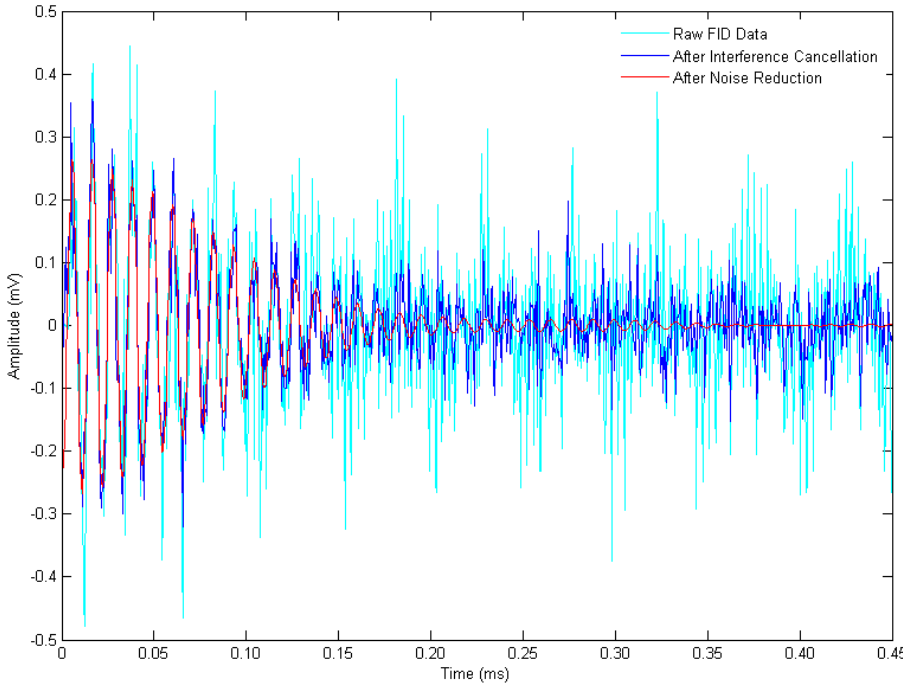
Figure 9. The waveforms of raw FID data (cyan), and the data after interference cancellation (blue) and noise suppression (red).